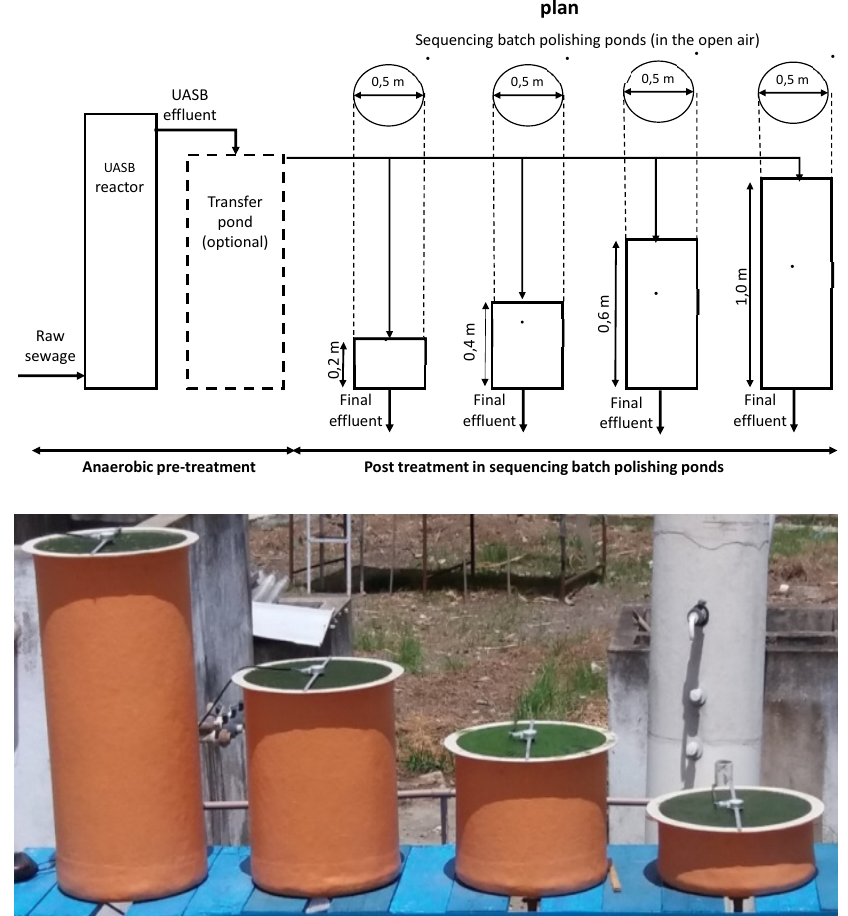
Figure 1. Flow sheet and photograph of a system of SBPPs with depths of 0.2; 0.4; 0.6 and 1.0 m with mild stirring of the pond